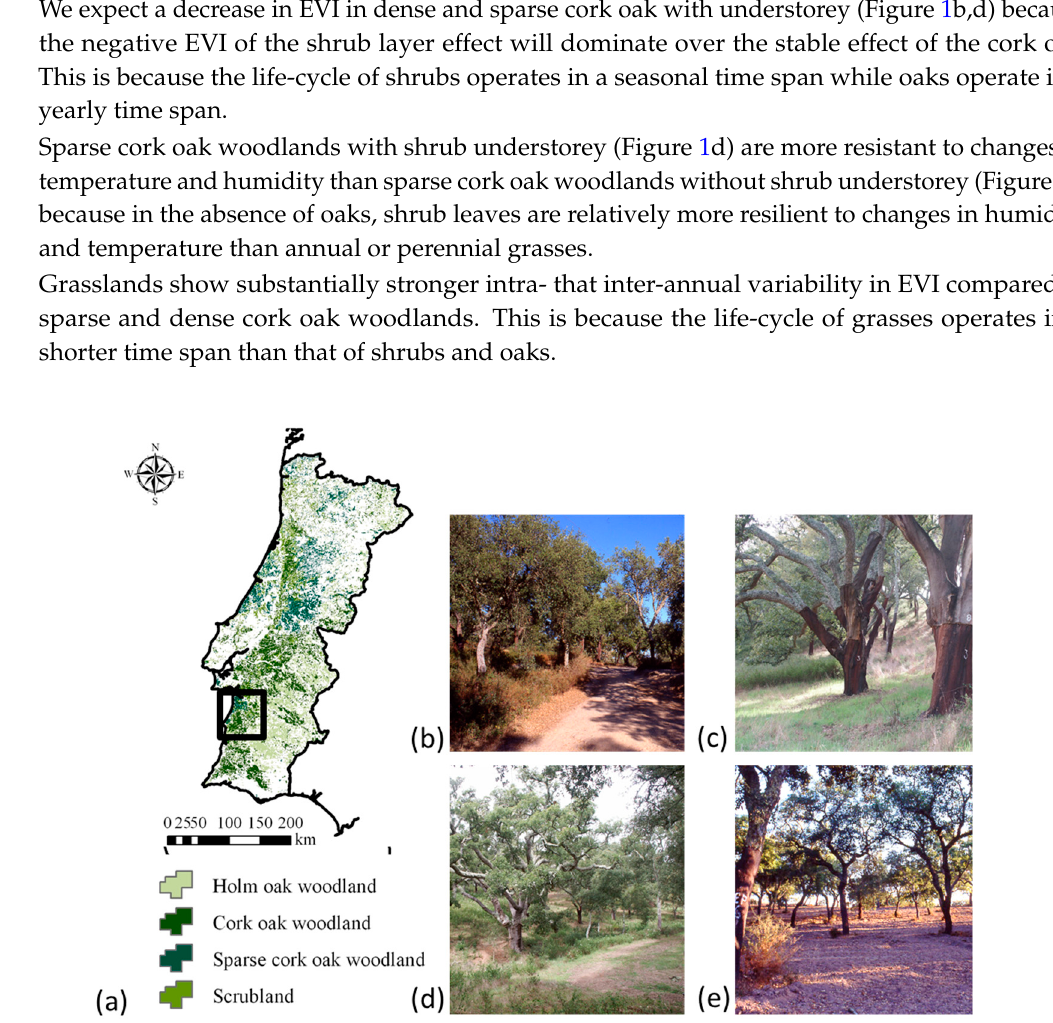
Figure 1. ( a ) Study area location and distribution of oak woodlands in Portugal; ( b ) Dense cork oak woodland with shrub understory; ( c ) Dense cork oak woodland without shrub understory; ( d ) Sparse cork oak woodland with shrub understory; ( e ) Sparse cork oak woodland without shrub understorey.